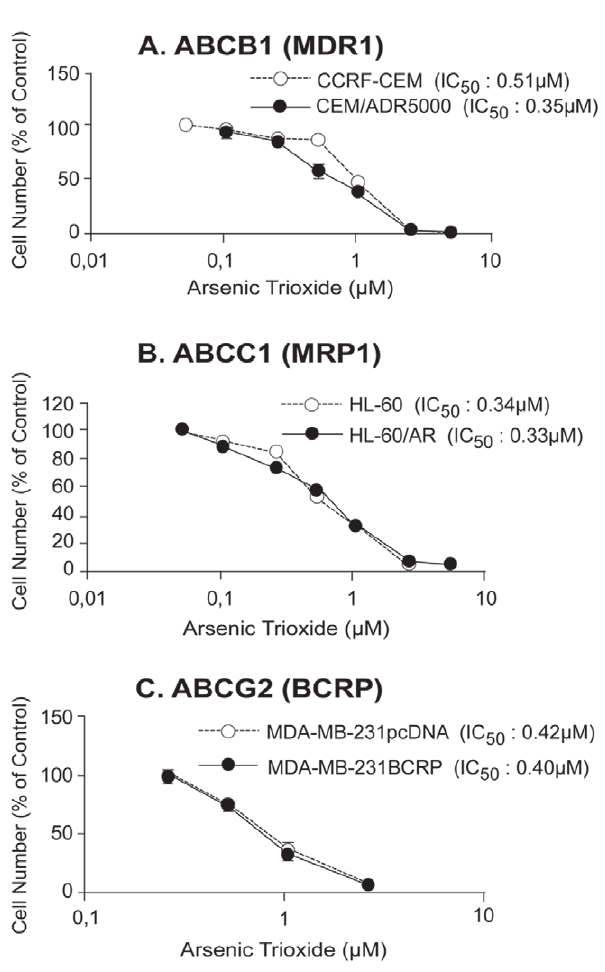
Figure 6. Cytotoxicity of sensitive and multidrug-resistant tumor cells to arsenic trioxide. (A) Sensitive CCRF-CEM and multidrug-resistant ABCB1 ( MDR1 ) - overexpressing CEM/ADR5000 cells; (B) sensitive HL60 and multidrug-resistant ABCC1 ( MRP1 ) - overexpressing HL60/AR cells; and (C) sensitive MDA-MB-231-pcDNA and multidrug- resistant ABCG2 ( BCRP ) - transduced MDA-MB-231-BCRP cells. Values represent the mean ( 6 SEM) of three independent experiments.